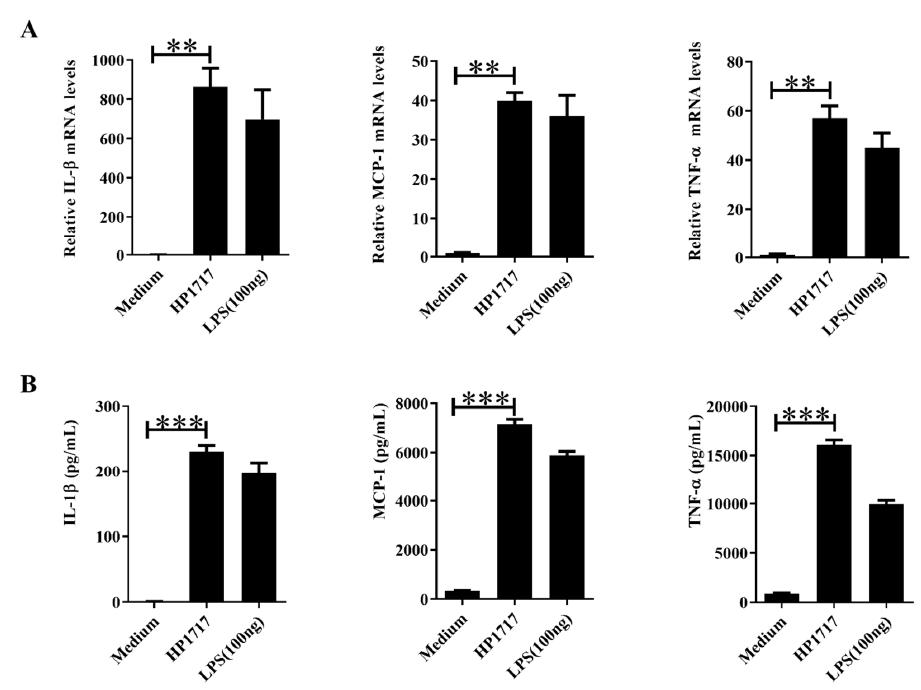
Figure 2. Induction of cytokine mRNA transcription and protein expression in RAW 264.7 macrophages